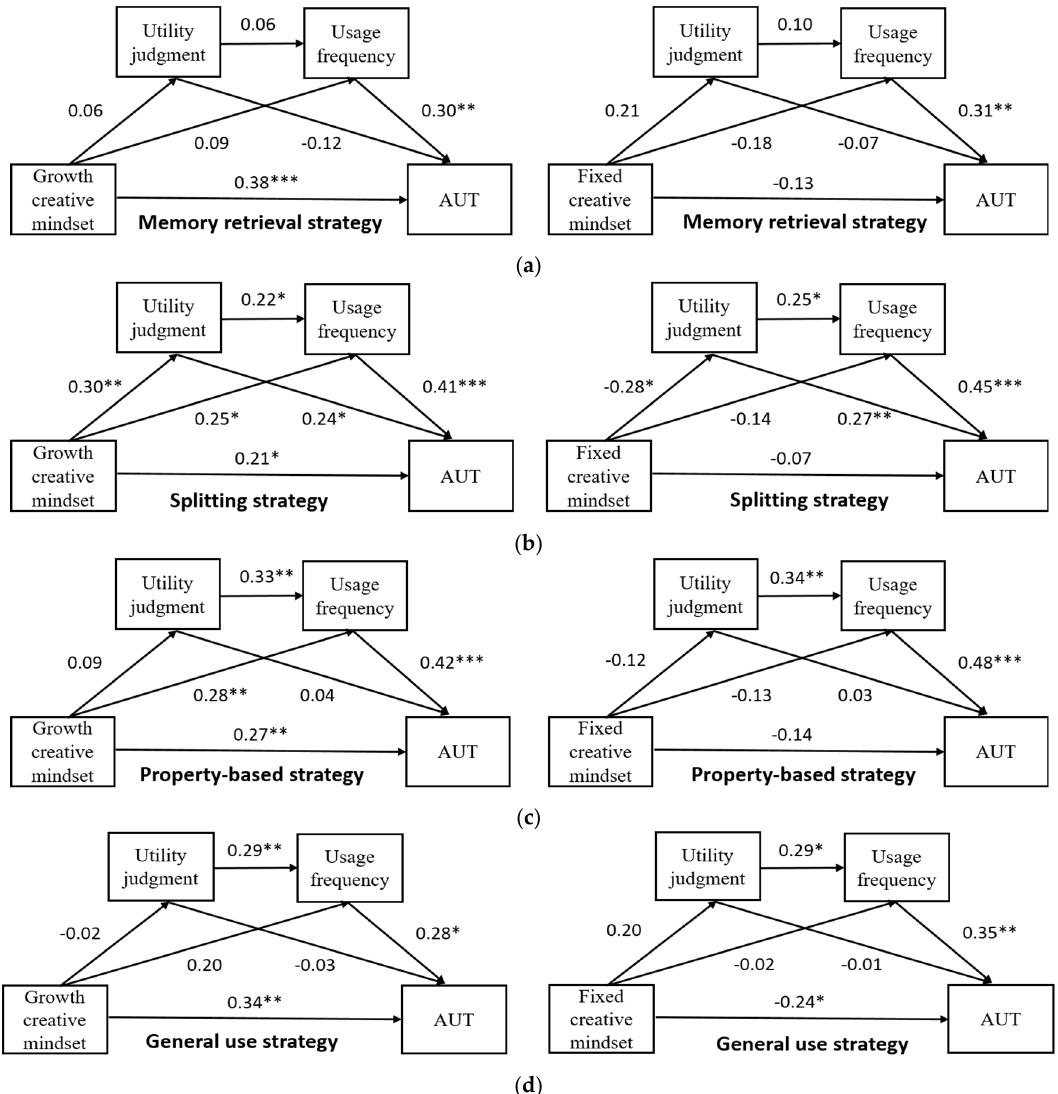
Figure 1. Sequential mediation model of growth/fixed creative mindset as predictor of creativity mediated by metacognitive Strategy monitoring and control for four different strategies. Standardized regression coefficients are displayed for all paths. Figures ( a – d ) represent memory retrieval strategy, splitting strategy, property-based strategy, and general use strategy, respectively. * p < 0.05; ** p < 0.01; *** p <